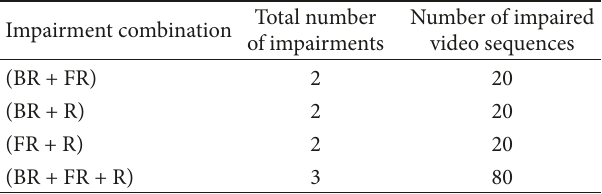
Table 7: Impairment choice for 140 video sequences (application QoS).